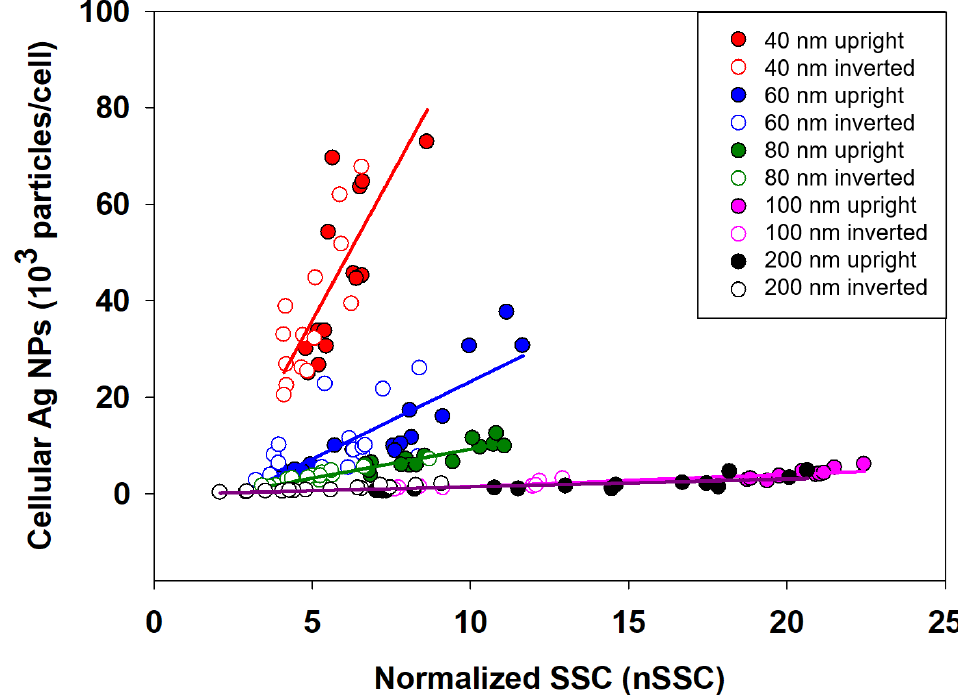
Figure 4. Linear regression between number of cellular Ag NPs and normalized SSC for 40, 60, 80, 100, and 200 nm particle sizes in upright and inverted configurations.